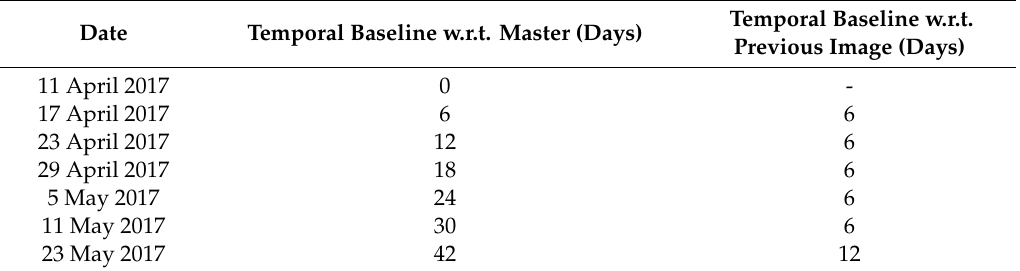
Table 3. Dataset used for the validation in northern Italy.